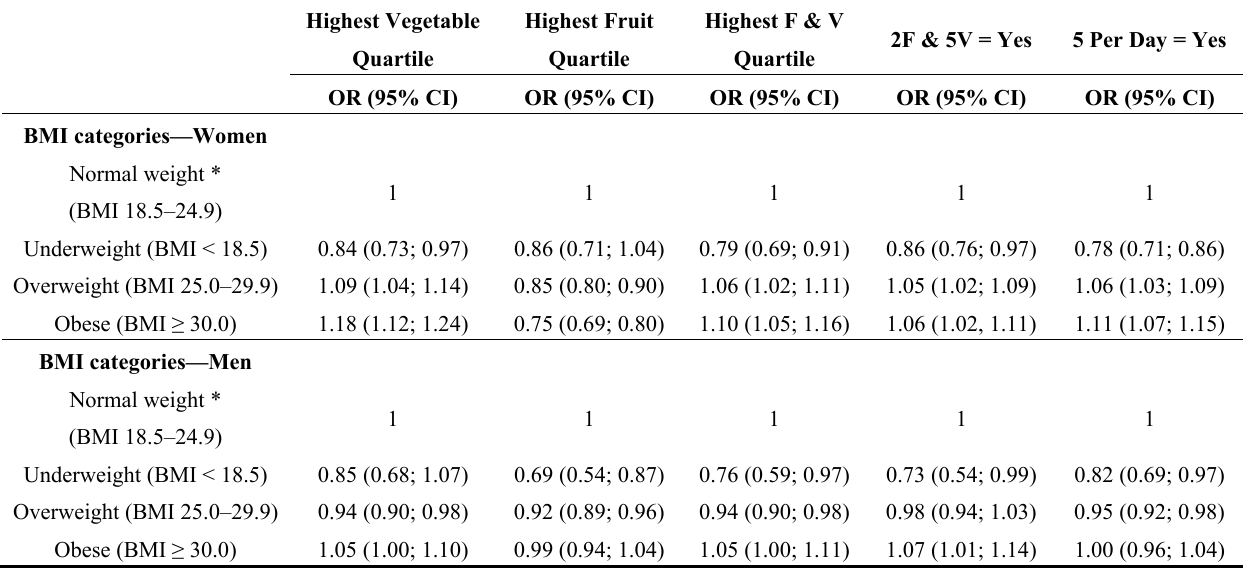
Table 3. Odds ratio of being in highest fruit and vegetable quartiles according to Body Mass Index (BMI) category, by